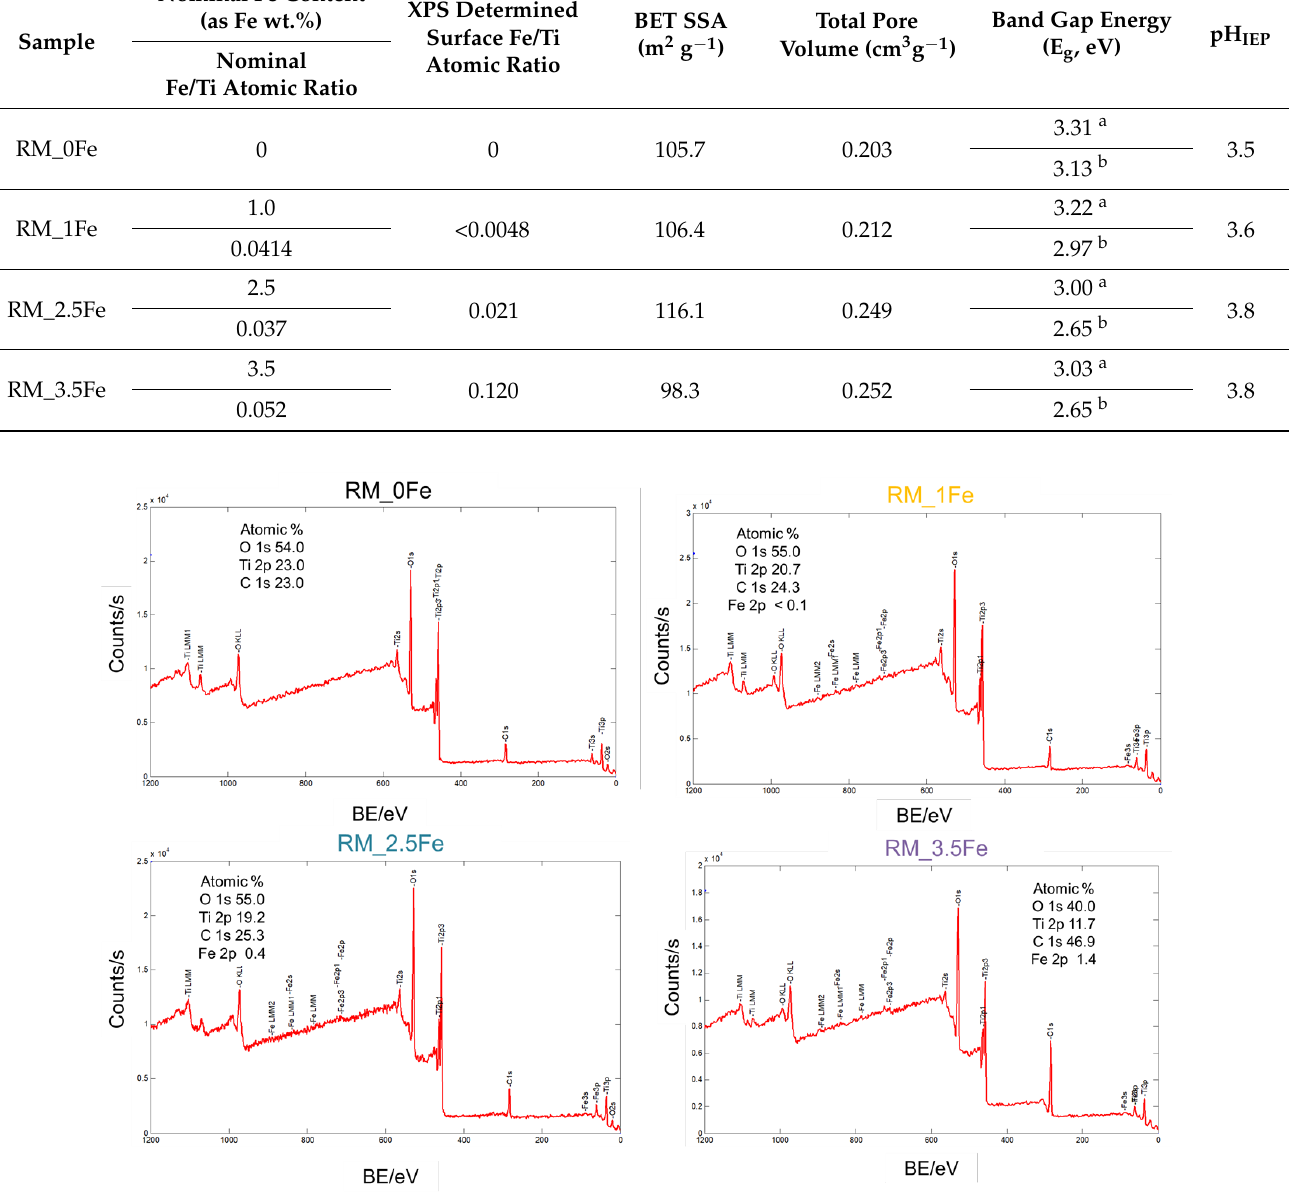
Figure 5. Survey XP spectra from which the surface Fe/Ti atomic ratio values in Table 2 have been determined. With all the samples, besides O, Ti (and Fe in doped ones) no other elements besides normally occurring adventitious C were detected.